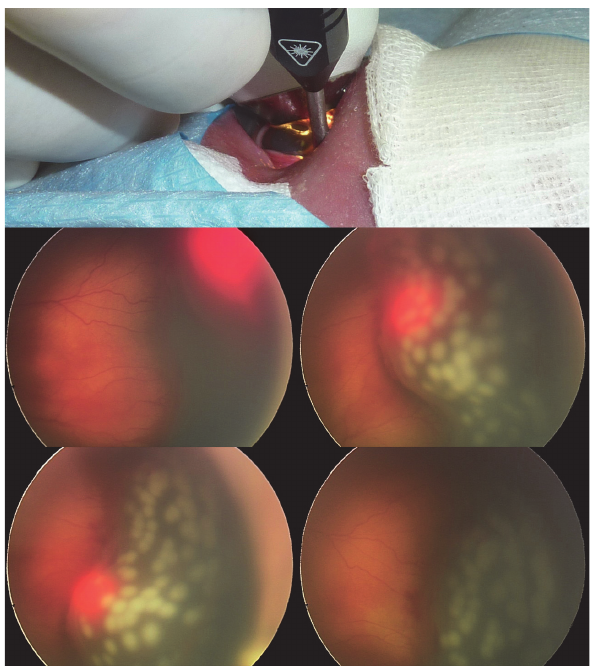
Fig. 2. CALCR treatment technique . Detailed images of the retina during the CALCR